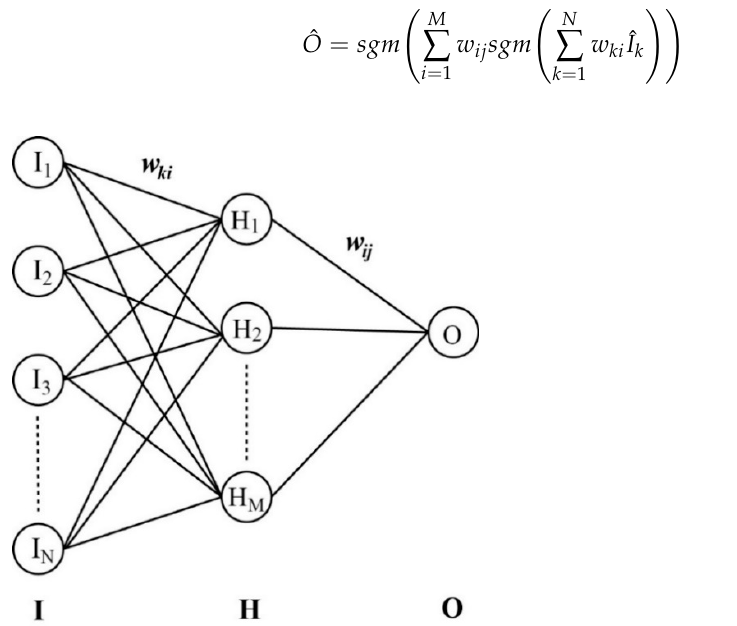
Figure 1. Schematic diagram of N × M × 1 neural network to derive a 3D-QSAR model for LogBB prediction. Columns I, H, and O indicate the input, hidden, and output layers, respectively. Neurons in the three layers are mutually related with the weighting matrices w ki and w ij .